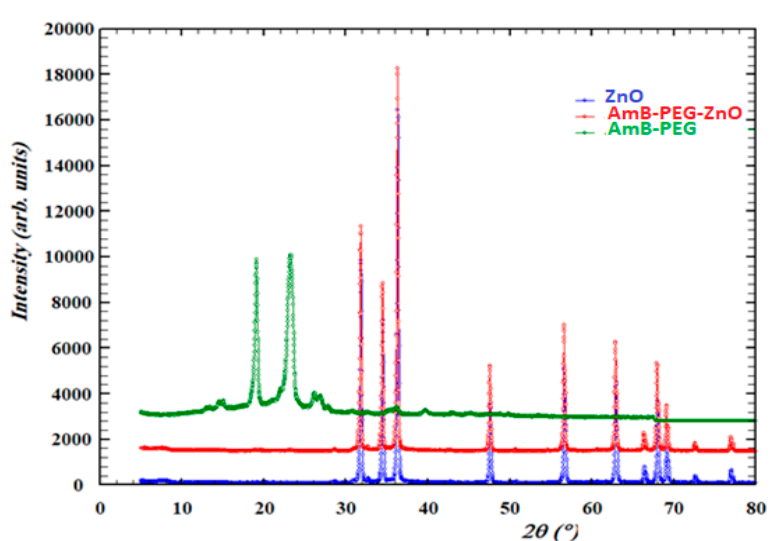
Figure 2. XRD patterns of pure ZnO, AMB-PEG and AMB-PEG-ZnO nanoparticles.